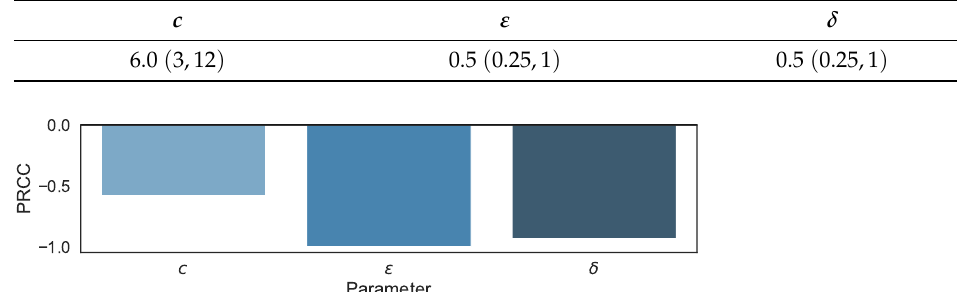
Figure 1. Partial rank correlation coefficient (PRCC) results in the biphasic model.